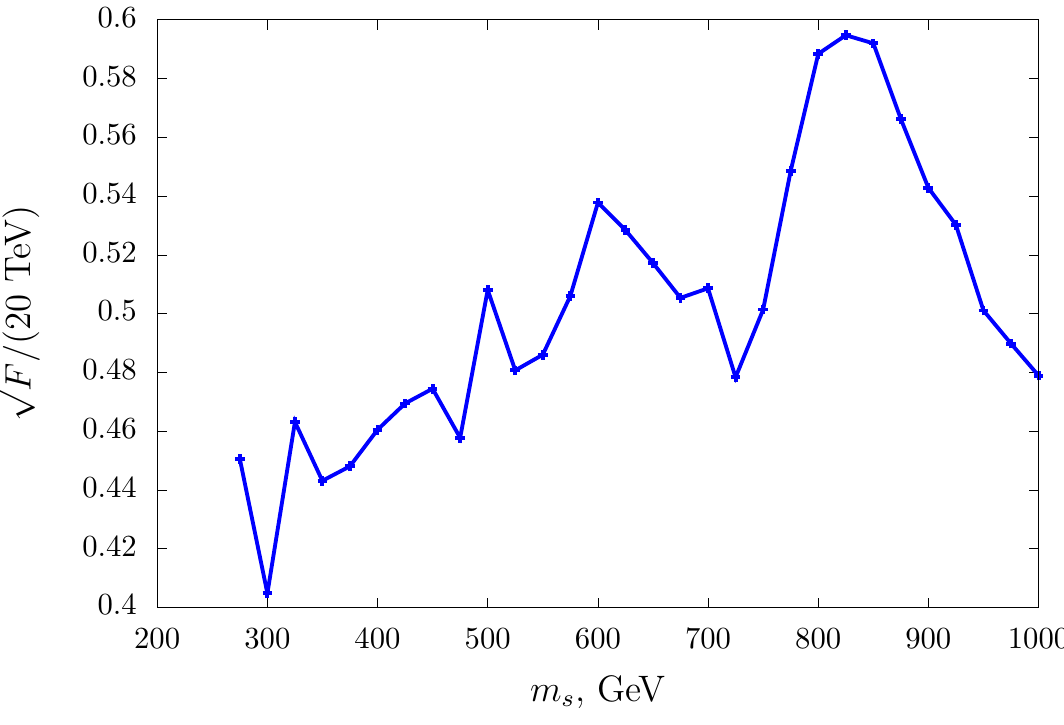
Figure 10. Lower limit on p F obtained using the upper limit on M 3 =F ((cid:12)gure 9) and a conser- vative lower bound M 3 & 2 TeV from experimental data [59{65] at p S = 13